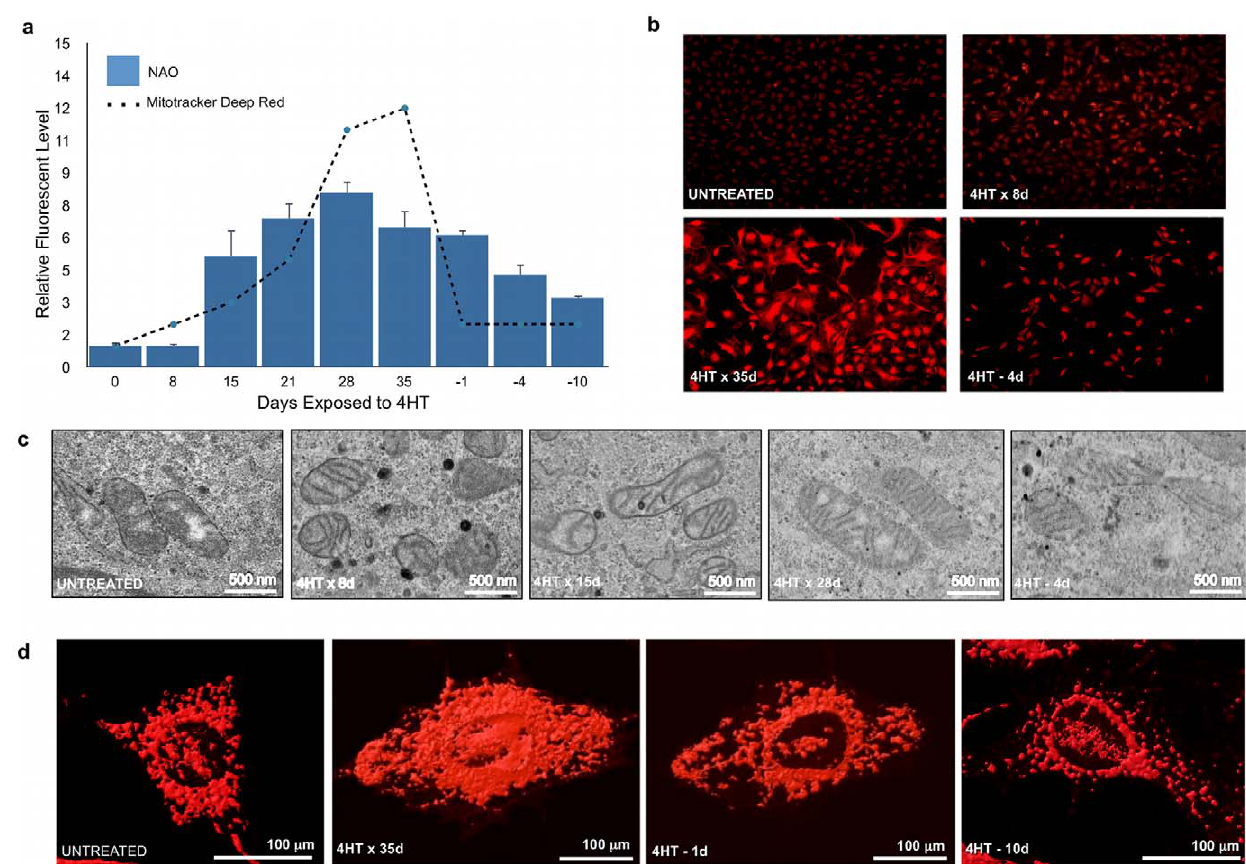
Figure 2. Temporal changes in mitochondrial density and structure in response to Myc. ( a ) Mitochondrial Mass . MycER cells were exposed to 4-HT for up to 35 d at which point 4-HT was removed. At the indicated times, cells were stained with NAO and MitoTracker Deep Red and analyzed by flow cytometry. Values are expressed relative to control cells not exposed to 4-HT, which were arbitrarily set to a value of one. ( b ) Mitochondrial mass by microscopy . MycER cells stained with MitoTracker Red were observed by epifluorescence microscopy at low power. The intensity of staining is consistent with the finding from flow cytometry. ( c ) Mitochondrial ultrastructure . MycER cells were exposed to 4-HT for the indicated times and observed by transmission electron microscopy. Representative mitochondria from each time point are depicted. Note that the untreated cells had small, cristae-deficient mitochondrion similar to those of the myc 2 / 2 cells. After several weeks of Myc induction the mitochondria took on a more normal and mature appearance. The size of the mitochondria began to decrease as 4-HT was removed from the media. The addition of 4-HT to cells lacking the MycER construct had no effect on any of the above-measured mitochondrial properties (not shown). ( d ) Mitochondrial shape . MycER cells were observed under live confocal microscopy either prior to or following the addition of 4-HT for 35 days. 4-HT was then removed and the cells were imaged again 1 day or 10 days later. Mitochondria were stained with MitoTracker Deep Red and 3-dimensional reconstructions of the cells were performed from a series of z-stacks. Shown are representative images with a space-filling overlay to emphasize the mitochondria. Note the loss of total mitochondria and the decrease in interconnectivity upon removal of 4-HT. Additional cells can be seen in a video detailing the three- dimensional structure (Video